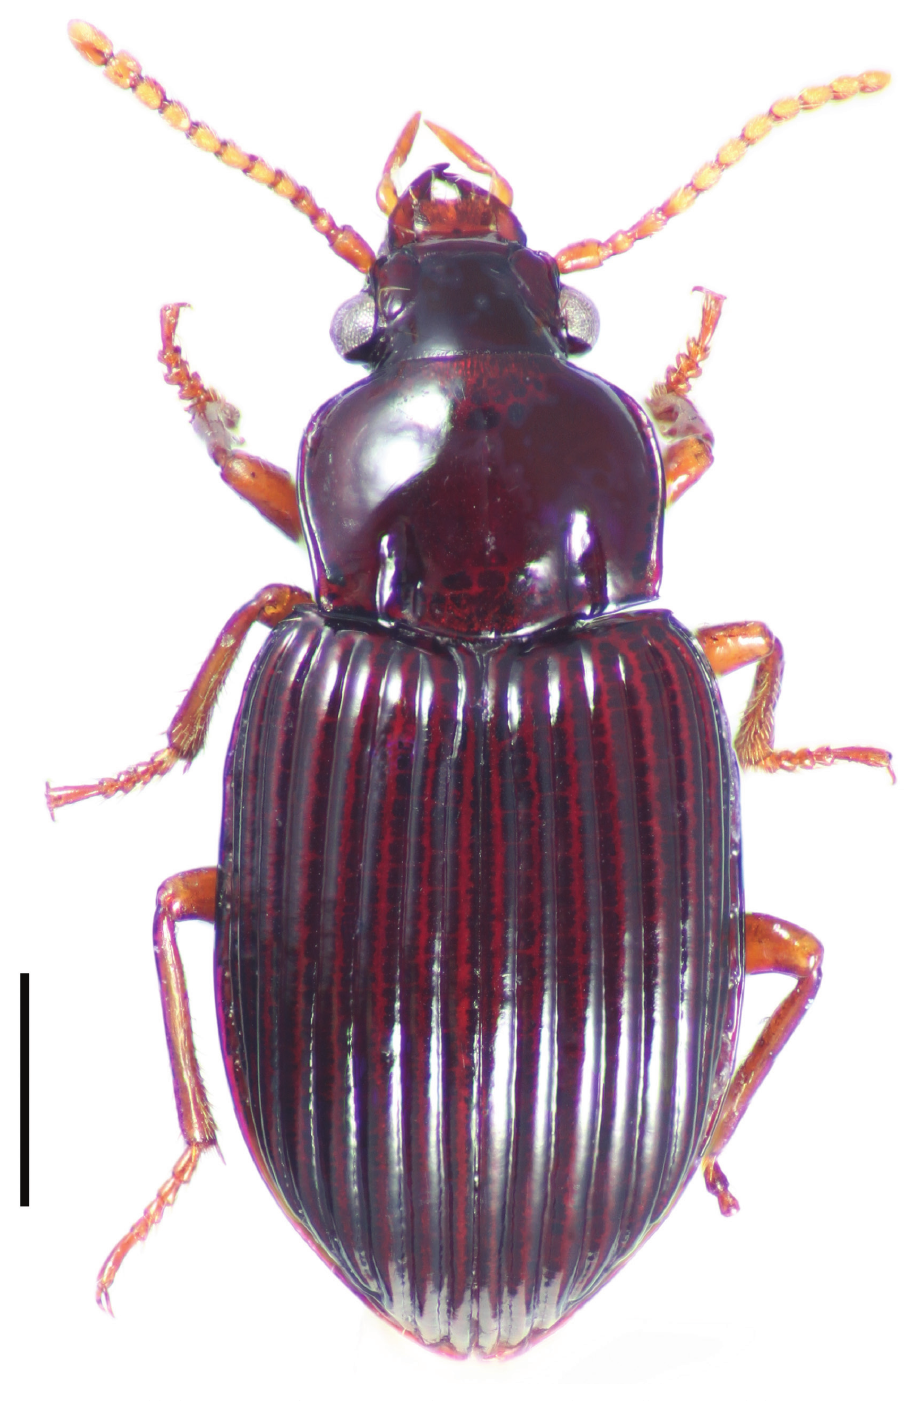
Figure 4. Dorsal habitus image of Cratocerus multisetosus Grzymala & Will, sp. n. Scale bar = 1.0